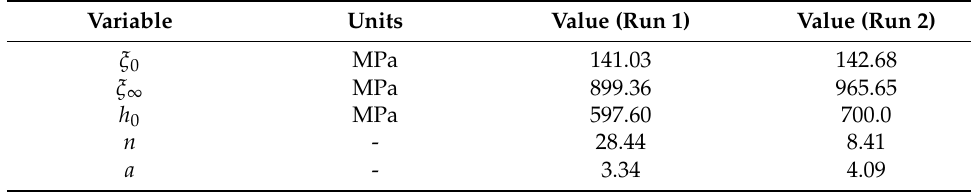
Table 8. The optimal parameters of the phenomenological CP model.